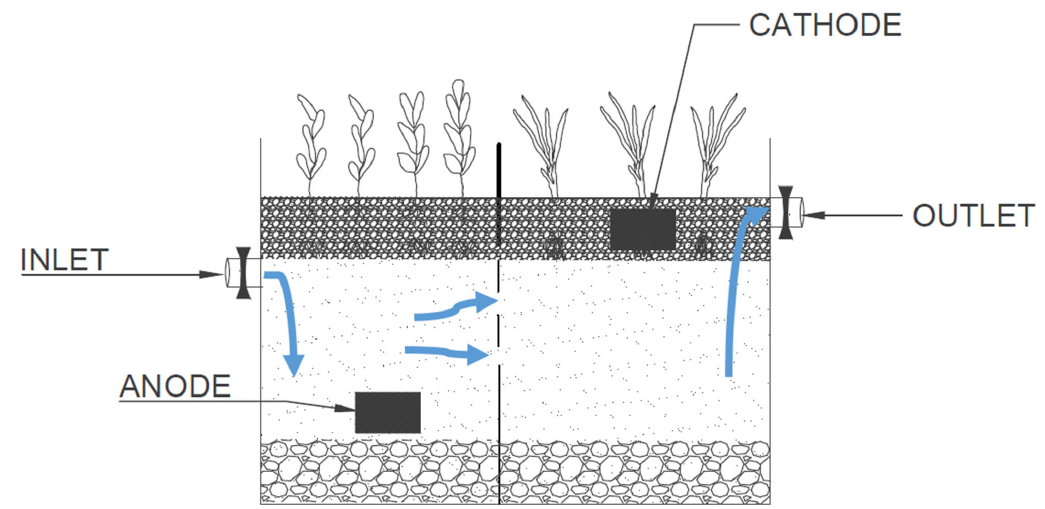
Figure 13. Representation of the vertical ‐ flow CW ‐ MFC ( adapted from Liu et al. (2019a) [43]). Ren et al. (2021) [37] treated swine wastewater using the alum sludge ‐ based hybrid CW ‐ MFC with a vertical up ‐ flow system in the first stage and a horizontal subsurface flow system in the second stage (Figure 14). Using dewatered alum sludge as the main sub ‐ strate, their system produced voltage and power density of 0.44 ± 0.09 V and 33.3 ± 13.81 mW/m 3 , respectively, in the first stage, and 0.34 ± 0.09 V and 9 ± 2.5 mW/m 3 , respectively, in the second stage. Xu et al. (2017) [82] built a stacked CW ‐ MFC (Figure 15), in which the anode electrode was made of stainless ‐ steel mesh sandwiched in graphite gravel, and the cathode electrode was made of stainless ‐ steel mesh with a thin layer of particle ‐ activated carbon. Their system, fed with synthetic wastewater, showed changes in the COD ‐ re ‐ moval efficiency from 83.2% in the upper part of the system to 88.7% in the outer part of the system. During a 3 ‐ month run period, the power density decreased from ~2 mW/m 2 (normalized to the cross ‐ section area of the reactor) on the second day of the operation to ~0.3 mW/m 2 after 60 days. This downturn was likely due to the deterioration of the air cathode. The cathode electrode (containing particle ‐ activated carbon) could have been contaminated with pollutants in the wastewater, resulting in reduced catalytic functions. The anode performance, however, showed minor changes over the operation period [82]. Gupta et al. (2021) [59] developed the algal ‐ assisted CW ‐ MFC integrated with a sand filter (Figure 16) for the treatment of various pollutants in wastewater and electricity genera ‐ tion. Their system produced the maximum power and current densities of 33.14 mW/m 3 (of the working volume of the anodic region) and 235 mA/m 3 , respectively.